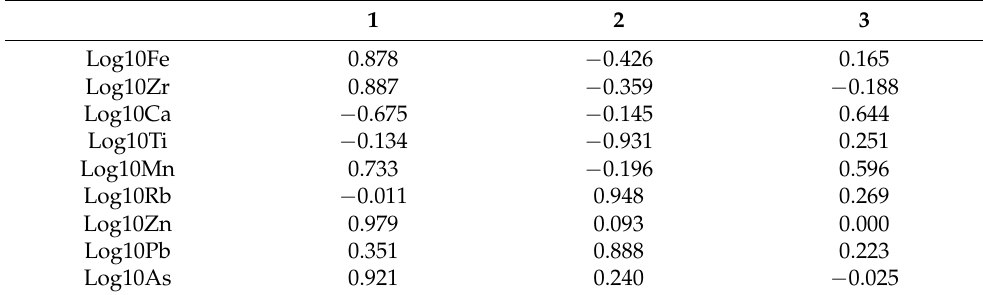
Table 4. The component matrix of